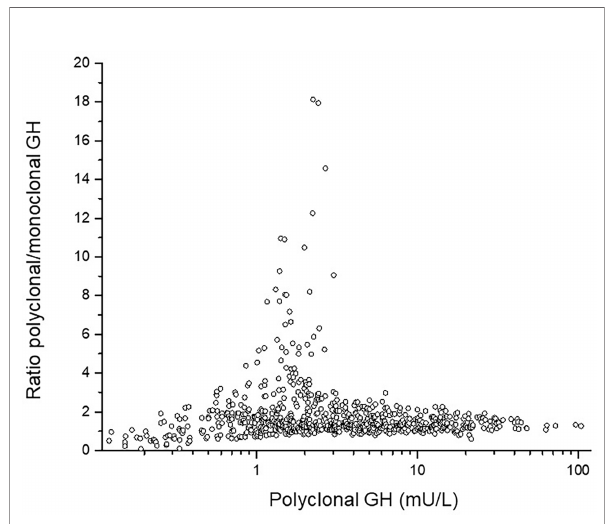
FIGURE 2 | The individual ratio polyclonal/monoclonal isoforms of GH in the y-axis versus total polyclonal GH antibodies in the x-axis. Notice the high ratio between 1 and 3 mU/L corresponding to 0.3 and 1